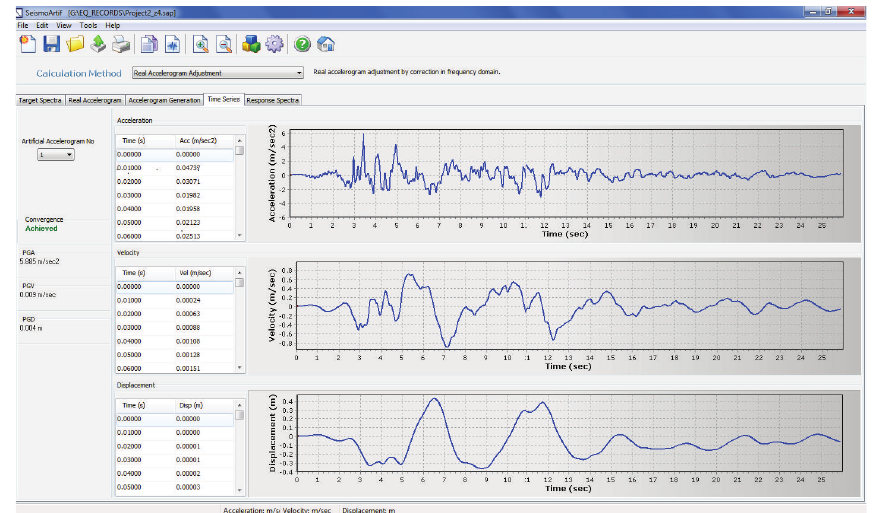
Figure 8: Calculated time series charts for the scaled Duzce EQ